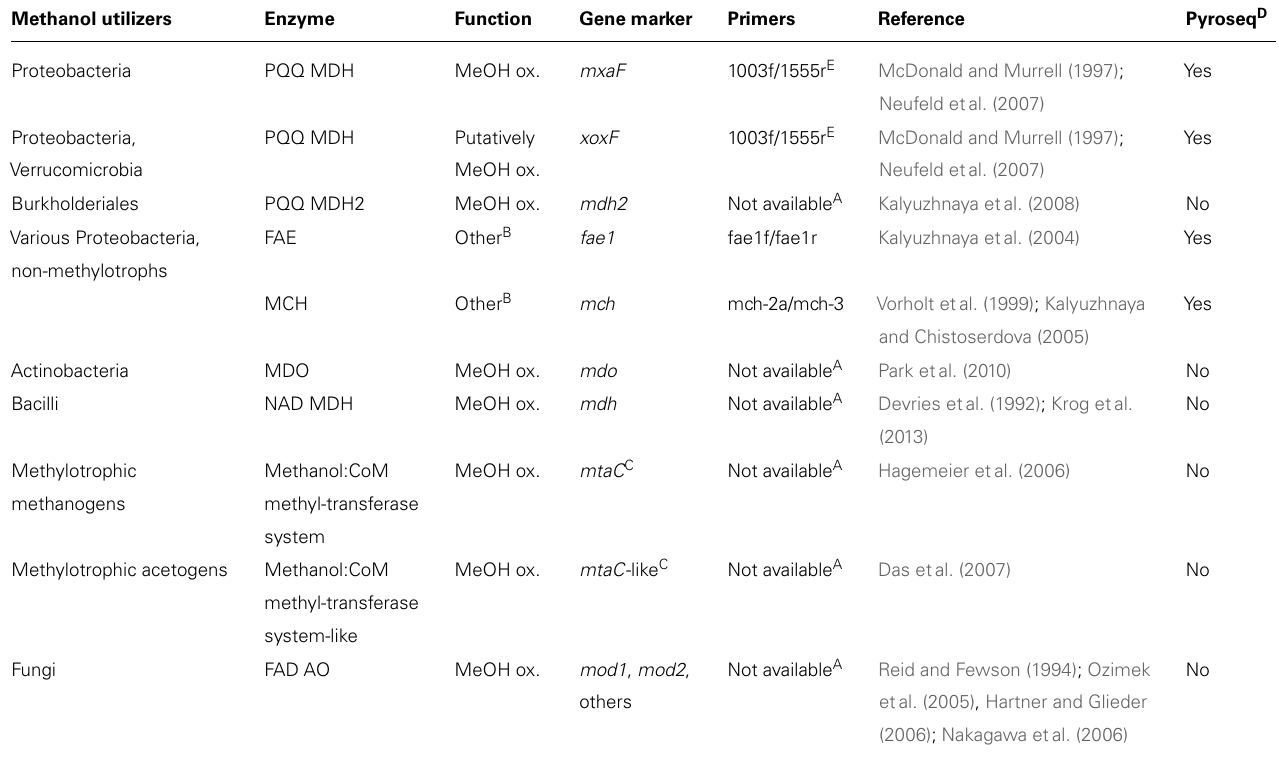
Table 3 | Gene markers of methanol-utilizing microorganisms for amplicon-based pyrosequencing or as targets for homology screens in metagenome, -trancriptome, or -proteome datasets. Methanol